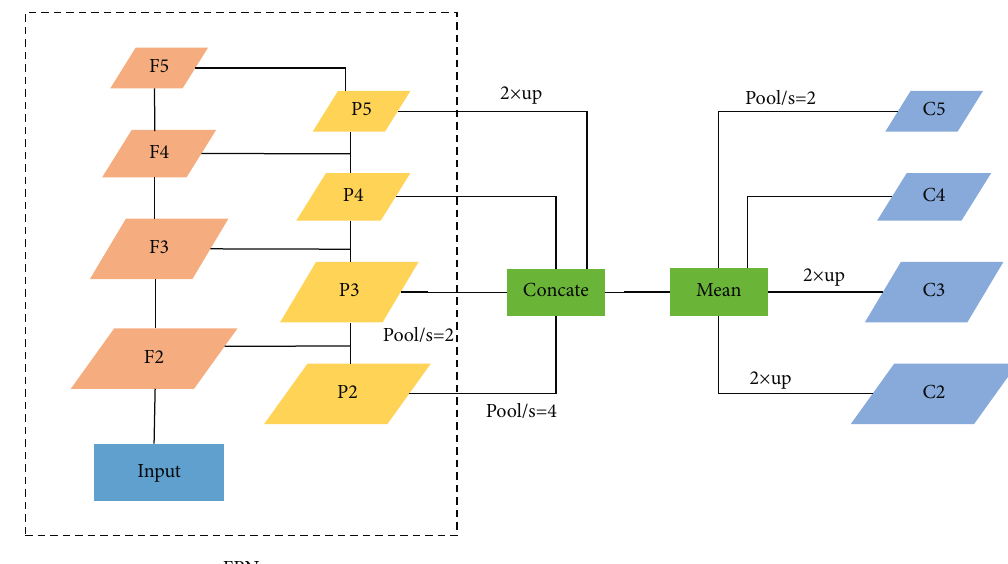
Figure 2: Multiscale feature fusion equalization network